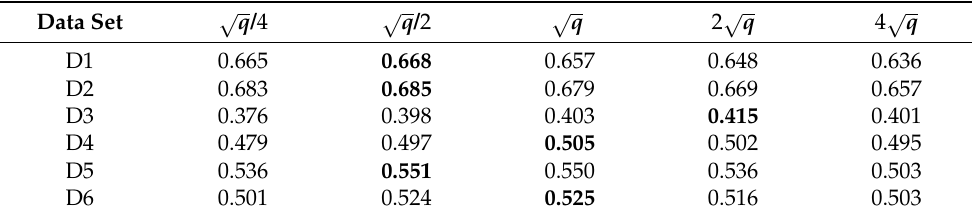
Table 3. Variance of the F-measure performance with the variance of the parameter K .